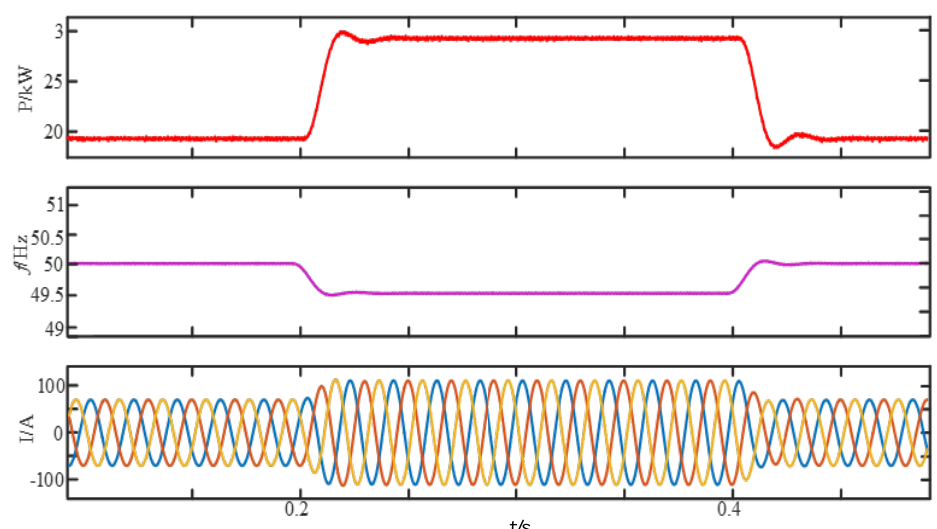
Figure 16. Simulation diagram when the grid frequency fluctuates.